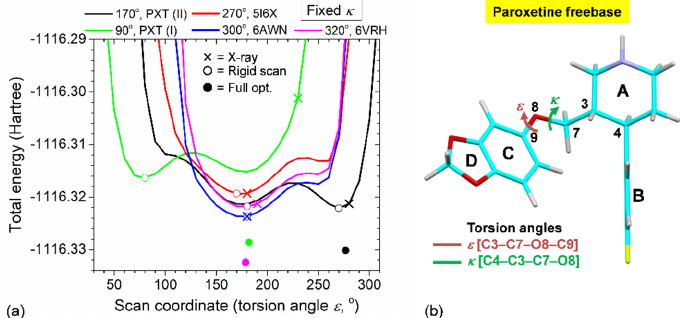
Figure 8. ( a ) PESs of PXT freebase derived from a rigid scan of torsion angle ε at different fixed torsion angle κ , mimicking PESs in three distinct lattice environments, i.e., PXT in an uncomplexed state with two molecules in the asymmetric unit ( κ = 180°, 300°), PXT in complex with β-CD (form II, κ = 170°; form I, κ = 90°) and PXT in complex with SERT (5I6X, κ = 270°; 6AWN, κ = 300°; 6VRH, κ = 320°). Note that 6VRH is obtained from cryo-EM; see text for more details. ( b ) Initial atomic coordinates for the rigid scan are taken from the PXT–β-CD complex (form II), showing two key torsion angles κ , ε that define the PXT conformational flexibility. The coordinates ( κ , ε ) of PXT from X-ray analysis ( ), rigid scan ( — E tot_min ) and full optimization ( — E opt ) by DFT calculations are marked. Note that E opt s of the three PXT–SERT complexes are coincident; see Figure 9 for the fully optimized PXT structures and Table 3 for the summary.